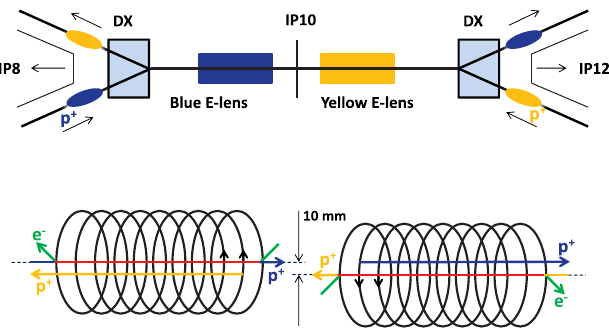
FIG. 2. Schematic not-to-scale illustration of the two e -lens locations. The top figure shows the plan view, while the bottom figure shows the side view, which indicates the vertical offset between the blue (left) and yellow (right) e -lenses.